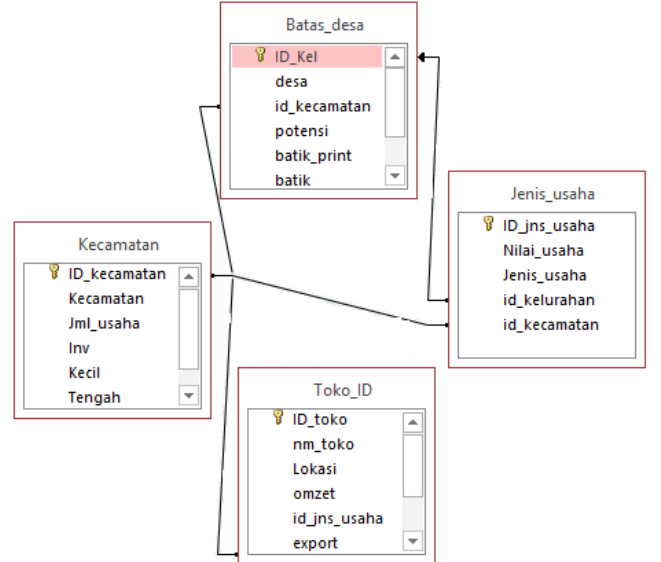
Fig 3. The ERD of proposed information